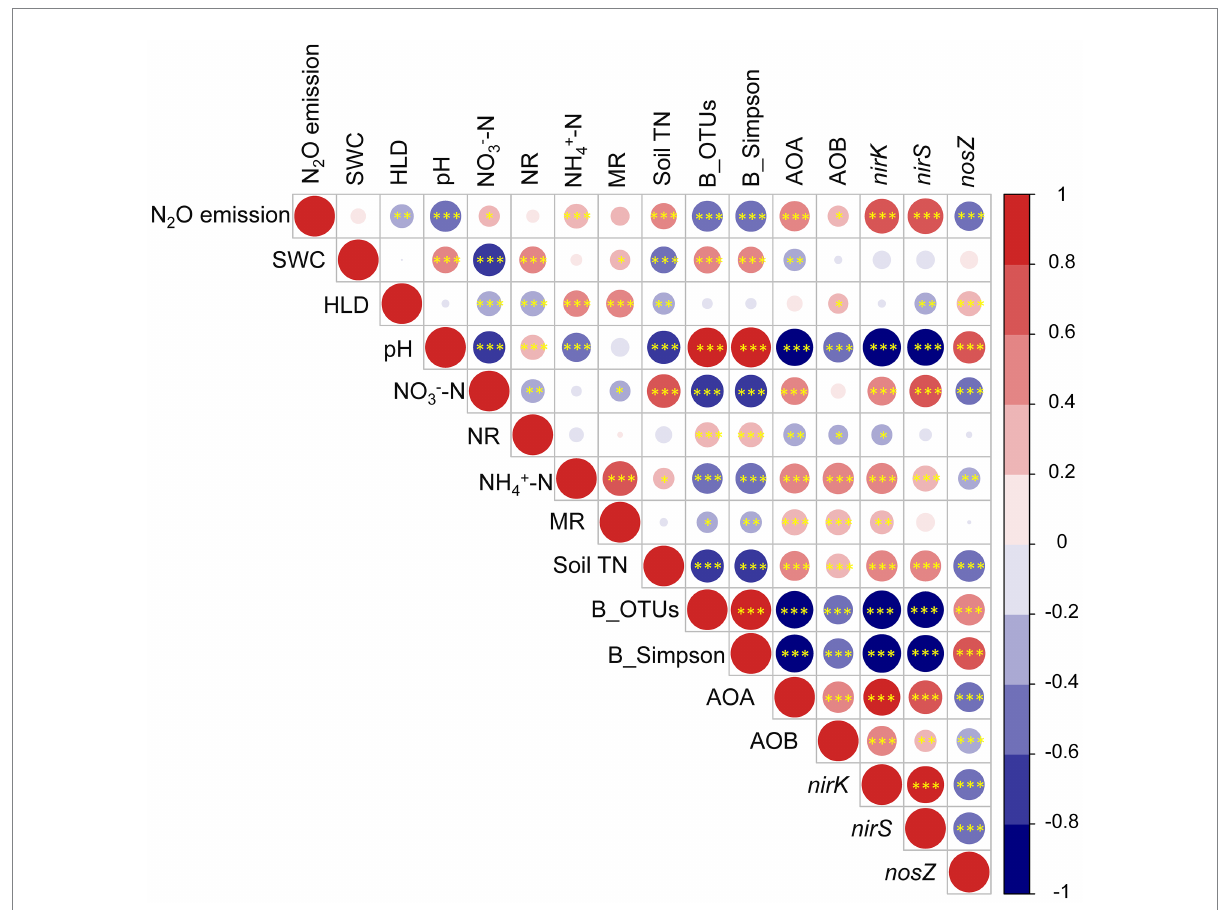
FIGURE 6 Pearson correlations among N 2 O emission, AMF (HLD), soil (SWC, pH, NO 3 − -N, NR, NH 4+ -N, MR, and TN), bacteria (OTUs, Simpson), and functional genes abundance (AOA, AOB, nirK , nirS , and nosZ ) for both years. HLD, hyphal length density; SWC, soil water content; NO 3— N, nitrate nitrogen; NH 4+ -N, ammonium nitrogen; NR, net nitrification rate; MR, net mineralization rate; soil TN, soil total nitrogen; B_OTUs, bacterial richness; B_Simpson, bacterial diversity; * p < 0.05, ** p < 0.01, and *** p <